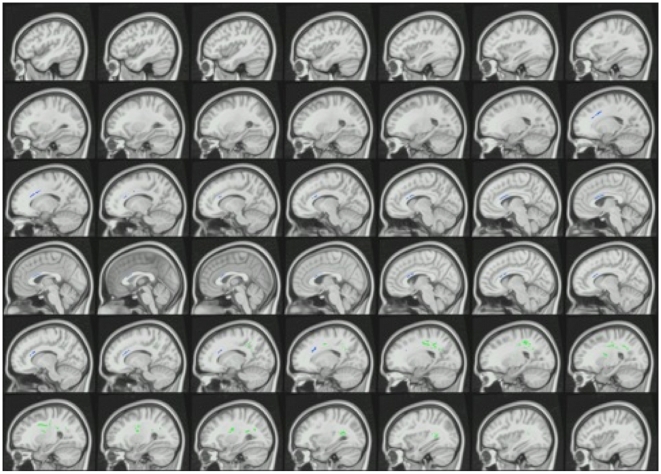
Clusters that had significantly lower fractional anisotropy (FA) in cocaine-dependent compared to control subjects are overlaid in color on a montage of sagittal slices of the MNI152 standard space template T1 brain image.Green voxels represent FA cluster 1 and blue voxels represent FA cluster 2 in Table 2. The slice in the upper left corner is in the left hemisphere; the lower right corner slice is in the right hemisphere. Note that the cluster colors were arbitrarily chosen to identify different clusters and do not represent a scale of t values.